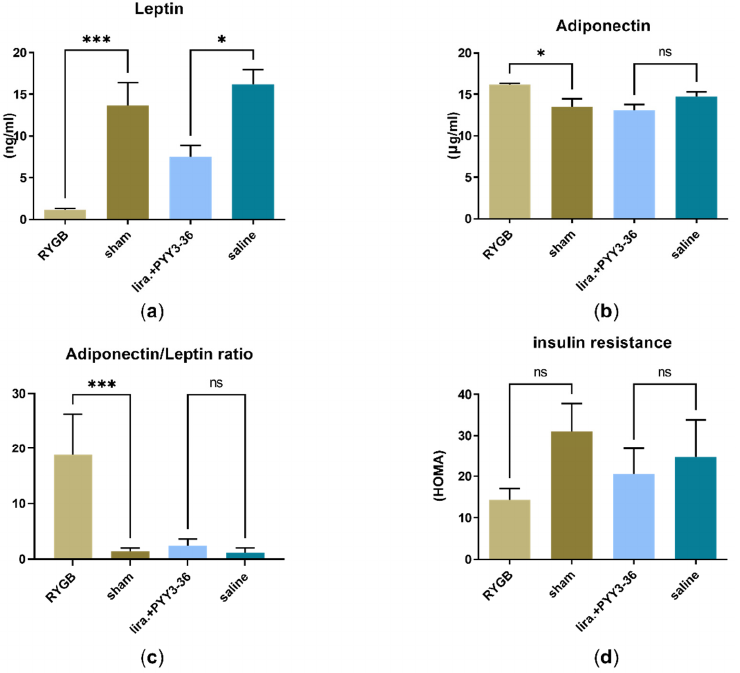
Figure 2. Metabolic improvements in RYGB vs. sham and liraglutide+PYY 3-36 vs. saline: ( a )